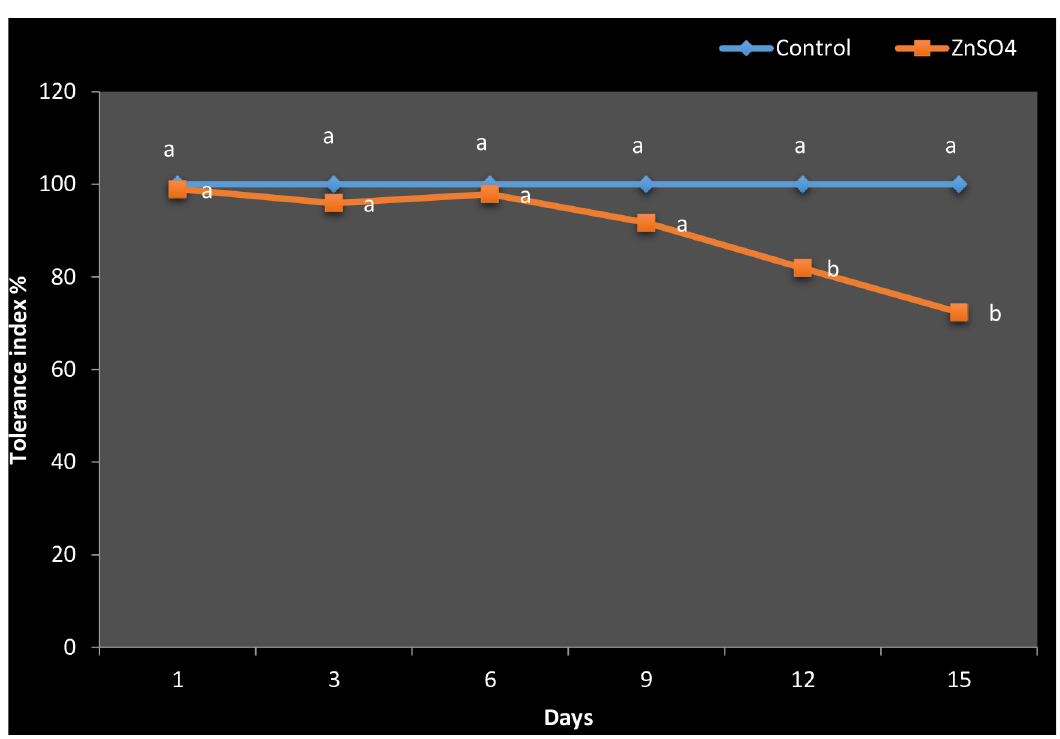
Fig 2. Tolerance index percentage of A . ilicifolius L. exposed to ZnSO 4 (4 mM).